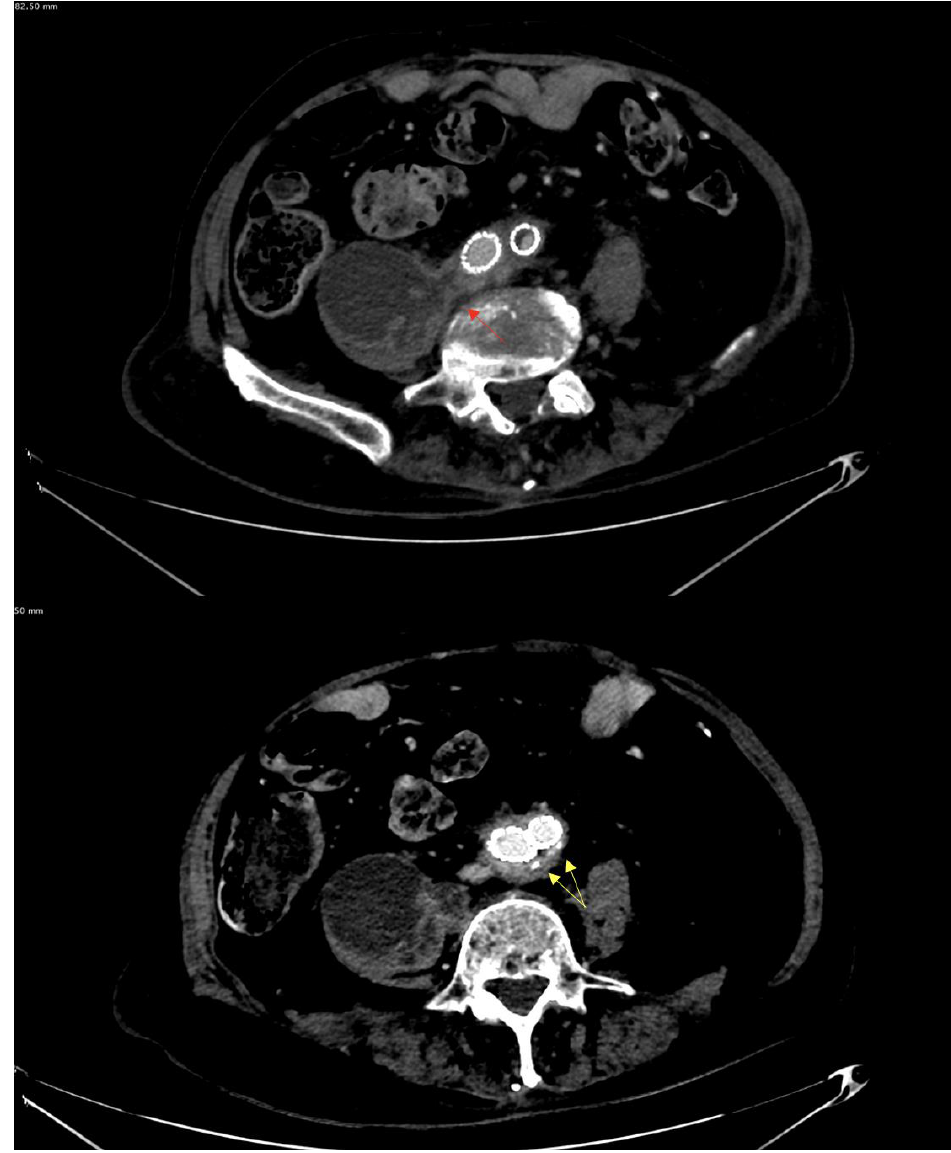
Figure 2. CTA scan of infected vascular endograft. (red arrow: psoas muscle abscess due to vascular endograft infection; yellow arrows: perigraft gas).